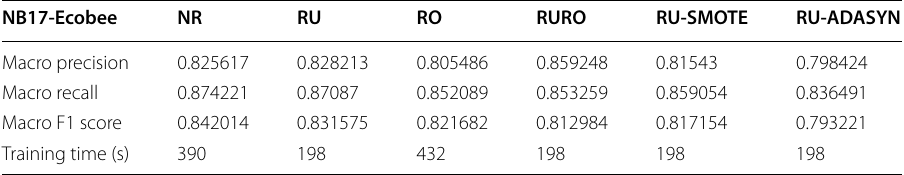
Table 38 ANN classification results for NB17-Ecobee on AWS with Spark for various resampling methods